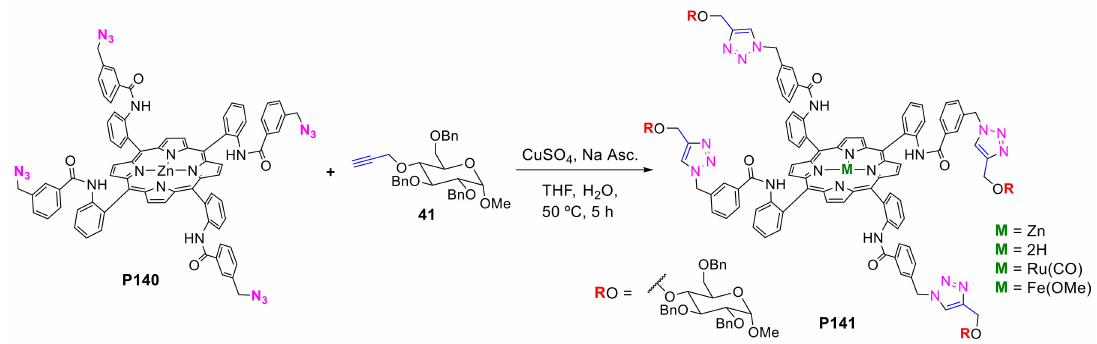
Scheme 47. Synthesis of glycoporphyrins used as catalysts in cyclopropanation and aziridination